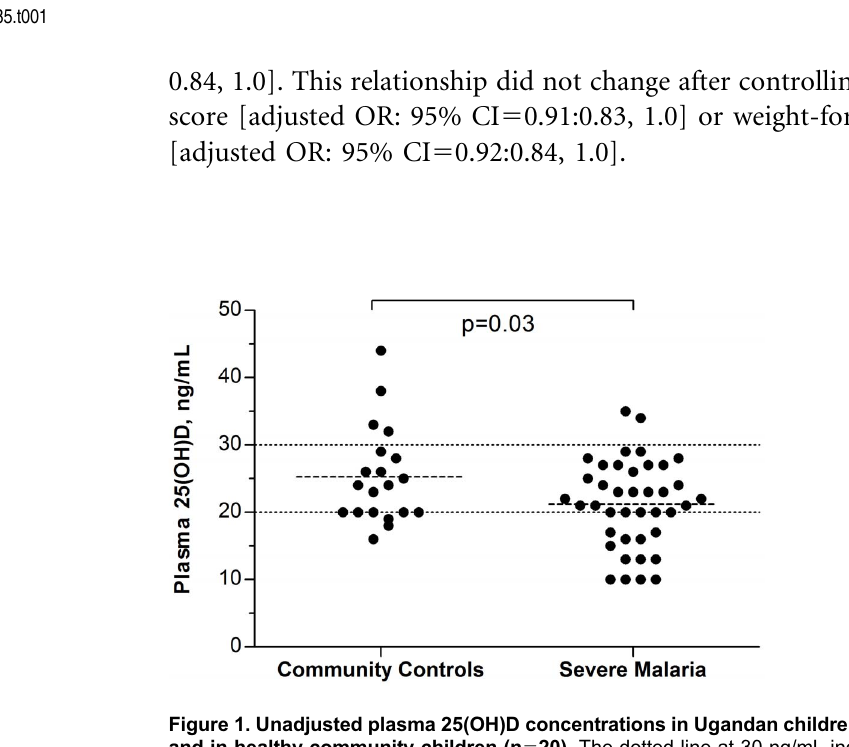
Figure 1. Unadjusted plasma 25(OH)D concentrations in Ugandan children with severe malaria (n 5 40) and in healthy community children (n 5 20). The dotted line at 30 ng/mL indicates the cutoff for vitamin D insufficiency, and the dotted line at 20 ng/mL indicates the cutoff for vitamin D deficiency. Dashed lines reflect mean 25(OH)D value for each study group.